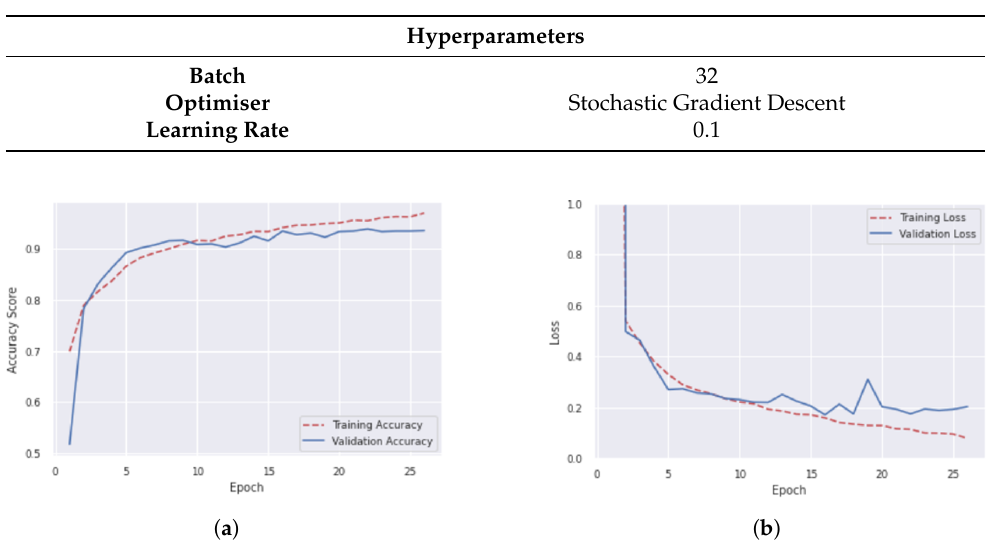
Table 11. Hyperparameters of the best performing ResNet50.